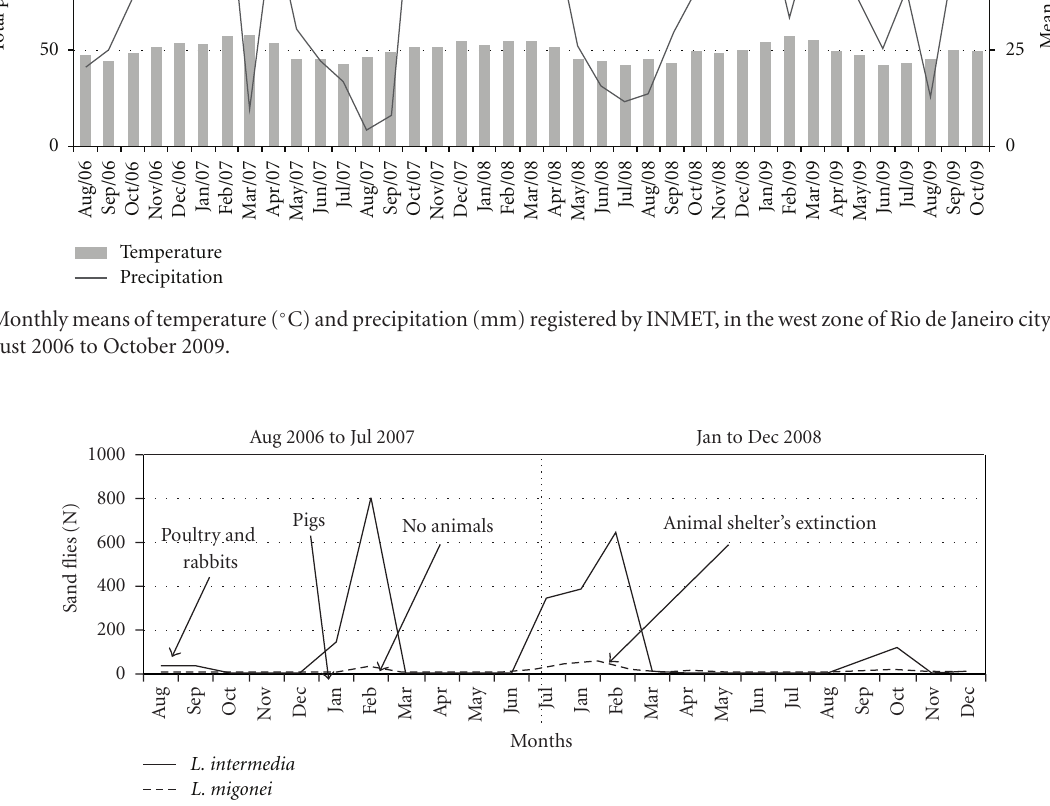
Figure 2: Environmental modifications and monthly capture of L. (N.) intermedia and L. migonei in the peridomicile of house 2, August 2006 to July 2007 and January to December 2008.